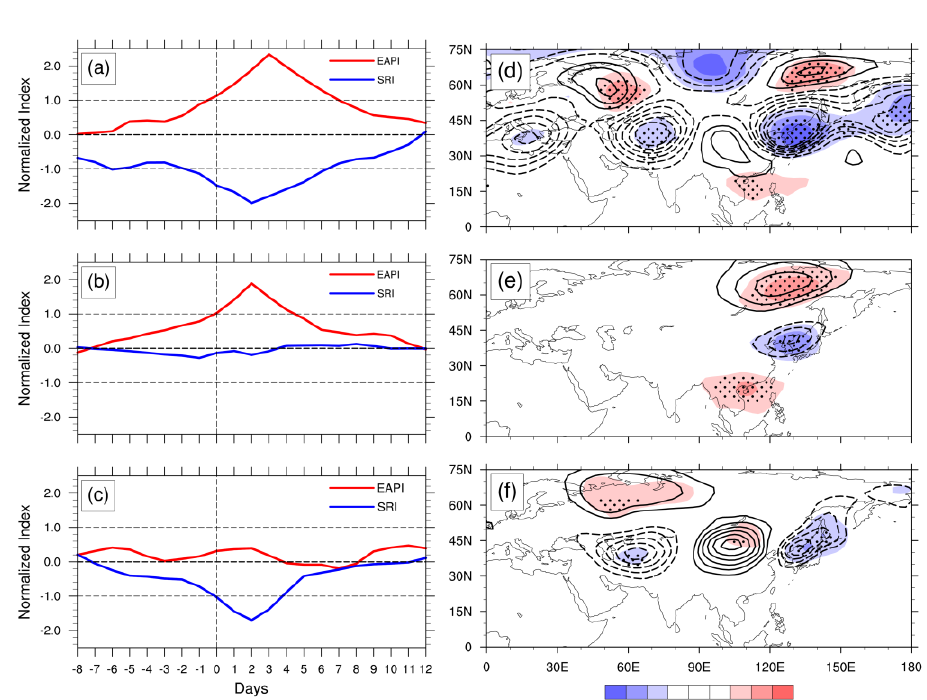
Figure 1. Composite indices of ( a ) EAP/SR-C; ( b ) EAP-S; and ( c ) SR-S patterns. The numbers of X-coordinates represent the days leading (negative) and lagging (positive) the start date. Composite averaged normalized height anomalies at 500 hPa (shading) and averaged geopotential height anomalies at 200 hPa (contours are from −120 dagpm to 120 dagpm with interval of 20 dagpm) of ( d ) EAP/SR-C; ( e ) EAP-S; and ( f ) SR-S patterns. The dotted filled shadings denote that normalized height anomalies are statistically significant at the 0.05